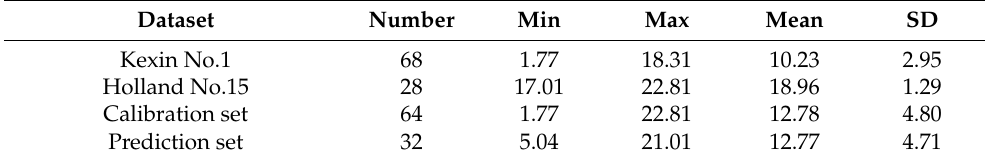
Table 1. Statistical results of measured starch content (g 100 g − 1 ) in potato samples of two varieties. Dataset Number Min Max